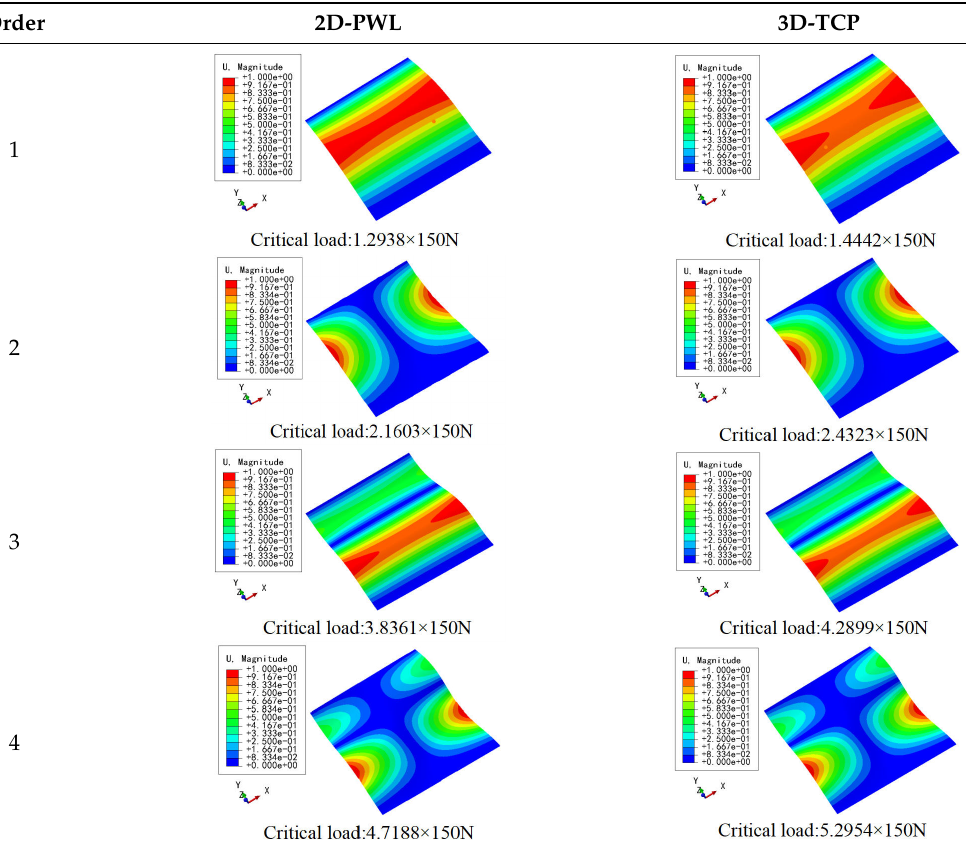
Table 16. Comparison of the first four buckling modes between 3D-TCP and 2D-PWL under the conditions in Case 7.